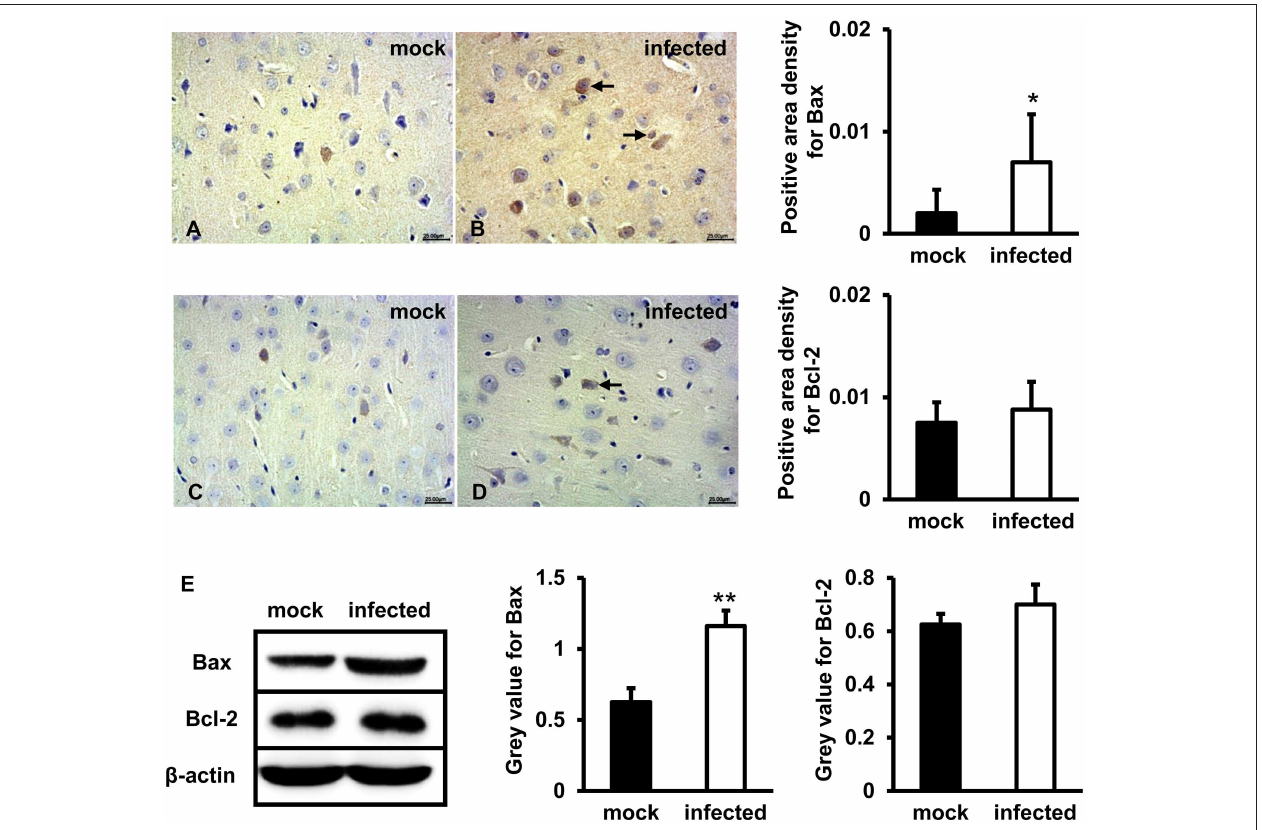
FIGURE 3 | Pro-apoptotic protein Bax but not Bcl-2 was upregulated following HEV infection. (A–D) HEV-RNA positive brain tissues collected on 14, 21, and 28 dpi were used for the immunohistochemistry study of Bax (rabbit polyclonal IgG) and Bcl-2(rabbit polyclonal IgG). Goat anti-rabbit IgG was chosen as secondary antibody. The positive signal was measured via the Motic Med 6.0 CMIAS Image Analysis System. Data showed that Bax was mainly distributed in cytosol of neuron cells, vascular endothelial cells and few microglial cells of HEV infection tissues with increased amount compared with mock group (* p < 0.05). Bcl-2 was detected in few neurons and vascular endothelial cells in both groups. (E) For western blot, HBMVECs were inoculated with 300 MOI HEV for 48h and HEV-negative homogenate served as control. Data showed that expression level of Bax was significantly higher in HBMVECs inoculated with HEV (** p < 0.01), but induction of Bcl-2 was not significant. For western blot, gray value was analyzed with ImageJ to quantitatively analyze the expression levels of targeted proteins according to the level of exposure gray (resolution). Data were finally normalized to the expression of anti- β